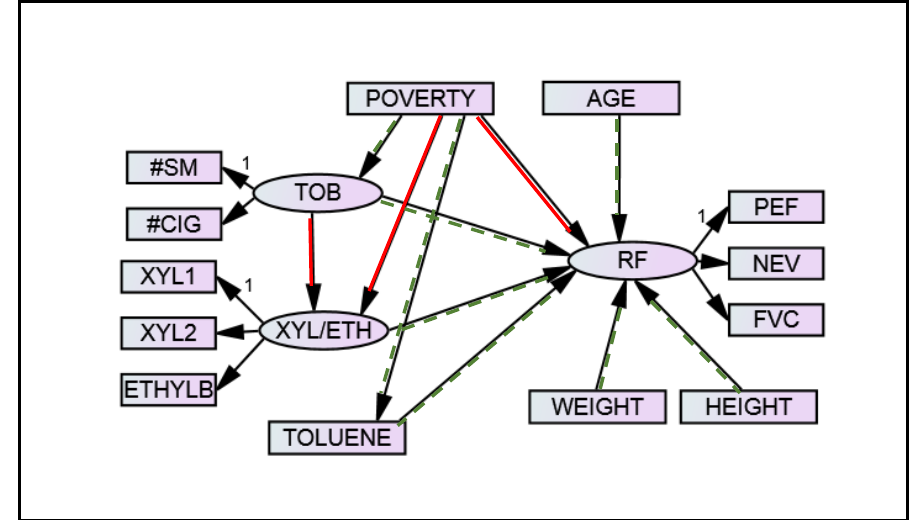
Figure 1. Hypothesized SEM of respiratory function, tobacco smoke exposure, and VOCs. This model predicts respiratory function based on tobacco smoke exposure and VOCs (xylene/ethylbenzene and toluene), controlling for the effects of age, height, weight, and poverty status on respiratory function and poverty status on tobacco smoke exposure and VOCs. Green (dotted) paths are significant at the α = 0.15 level; red (solid) paths are not significant at the 0.15 level. “1” identifies the observed variable within each latent variable whose factor loading was fixed to